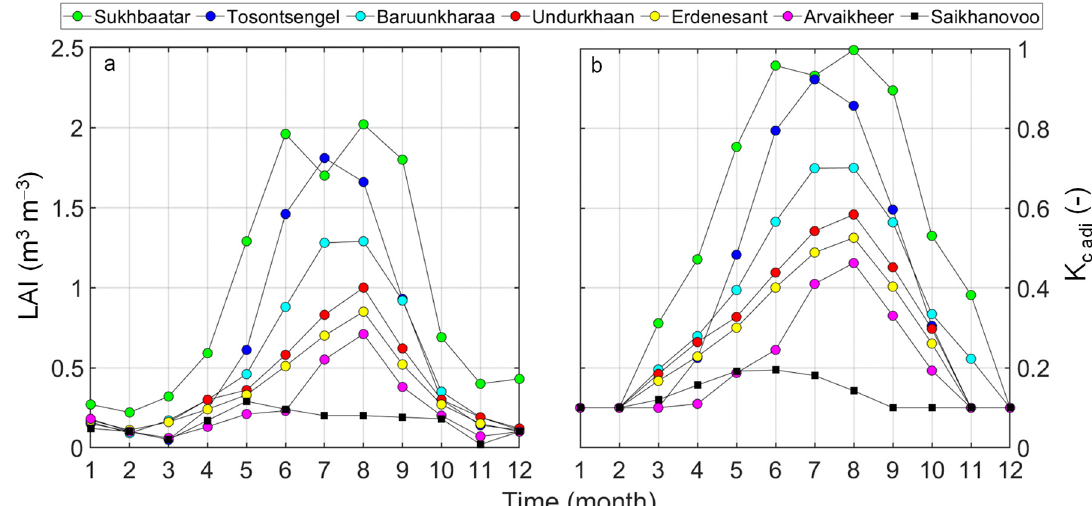
Figure 7. Mean monthly values of ( a ) leaf area index ( LAI ) and ( b ) crop coefficient, K c adjS at six weather stations (Sukhbaatar, Tosontsengel, Baruunkharaa, Undurkhaan, Erdenesant, Arvaikheer) in the steppe zone (colored circles) and crop coefficient, K c adjD at one weather station (Saikhanovoo) in the Gobi Desert (black square).